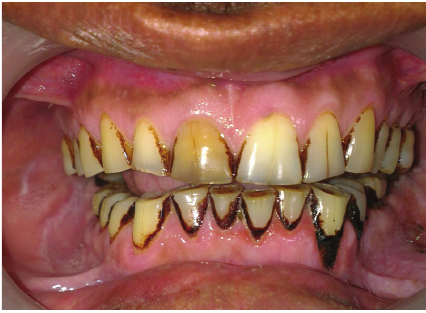
Figure 3: Intraoral periapical radiograph showing the periapical lesion associated with the right maxillary central